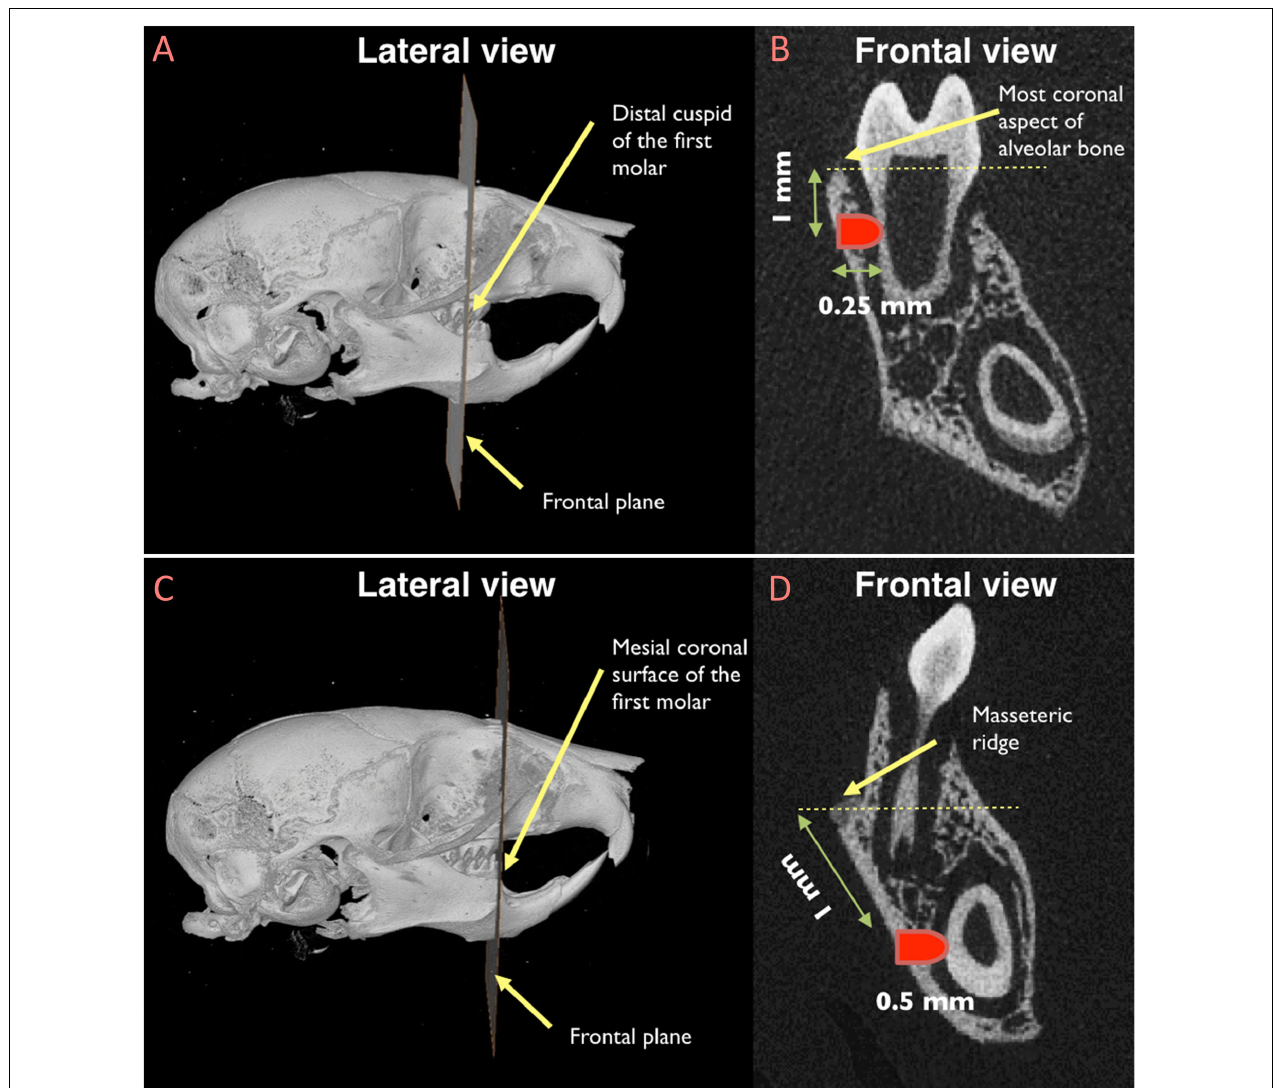
FIGURE 1 | Location of the sub-critical size fenestration periodontal defects in the mandibular first molar (A and B) and in the mandibular incisor (C and D) . (A) The distal cuspid of the first molar was used as the reference point to locate the frontal plane in correspondence of which the periodontal defect by the mandibular first molar would be created; (B) once the reference frontal plane was identified, the exact location of the defect was recognized by measuring a distance of 1 mm from the most coronal aspect of the alveolar bone; (C) the mesiocoronal surface of the first molar was utilized as the reference point to locate the frontal plane in correspondence of which the periodontal defect by the mandibular incisor would be created; (D) after identifying the reference frontal plane, the periodontal defect was created 1 mm apical to the masseteric